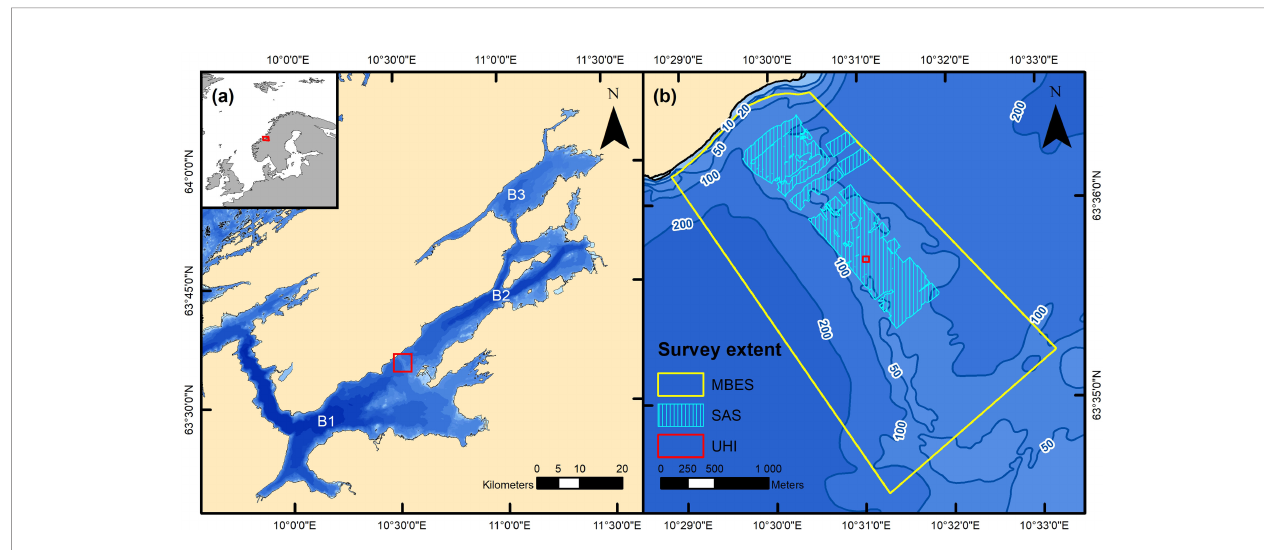
FIGURE 1 | The area surveyed in the current study. Panel (A) shows a map of the Trondheimsfjord with the fjord ’ s geographic position indicated in the upper left corner. B1, B2 and B3 correspond to the fjord ’ s outer, middle and inner basin, respectively. The red square indicates the position of the Tautra Ridge and the extent of panel (B) . Panel (B) shows a depth contour map of the most pronounced part of the Tautra Ridge (depths are given in meters) and the spatial extent of the datasets utilized in the study. The data were obtained using three different techniques: multibeam echo sounding (MBES), synthetic aperture sonar (SAS) imaging and underwater hyperspectral imaging (UHI). The maps were created in ArcMap (v. 10.8; Esri Inc., Redlands, USA; https://desktop.arcgis.com/en/arcmap/). The depth contour maps are based on data from the Norwegian Mapping Authority (Kartverket), available at